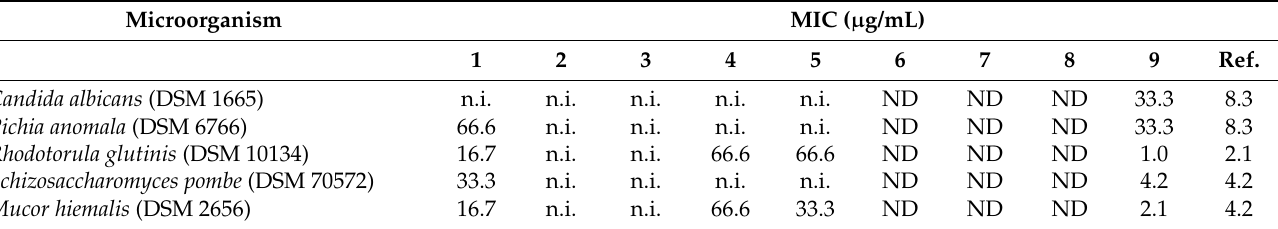
Table 5. Antifungal activities of compounds 1 – 9